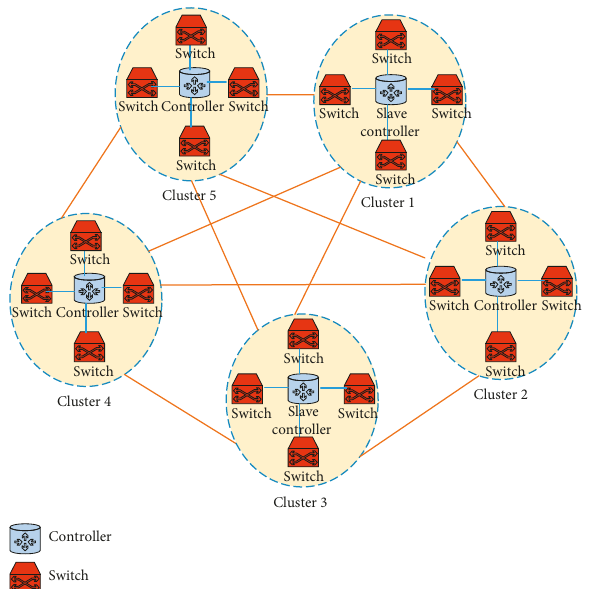
Figure 5: Five slave controllers connected in slave-slave architecture.